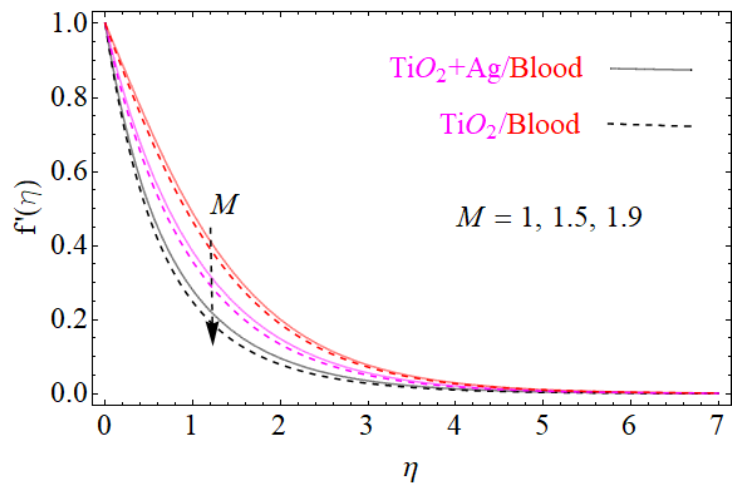
Figure 2. Effect of magnetic field on velocity profile.